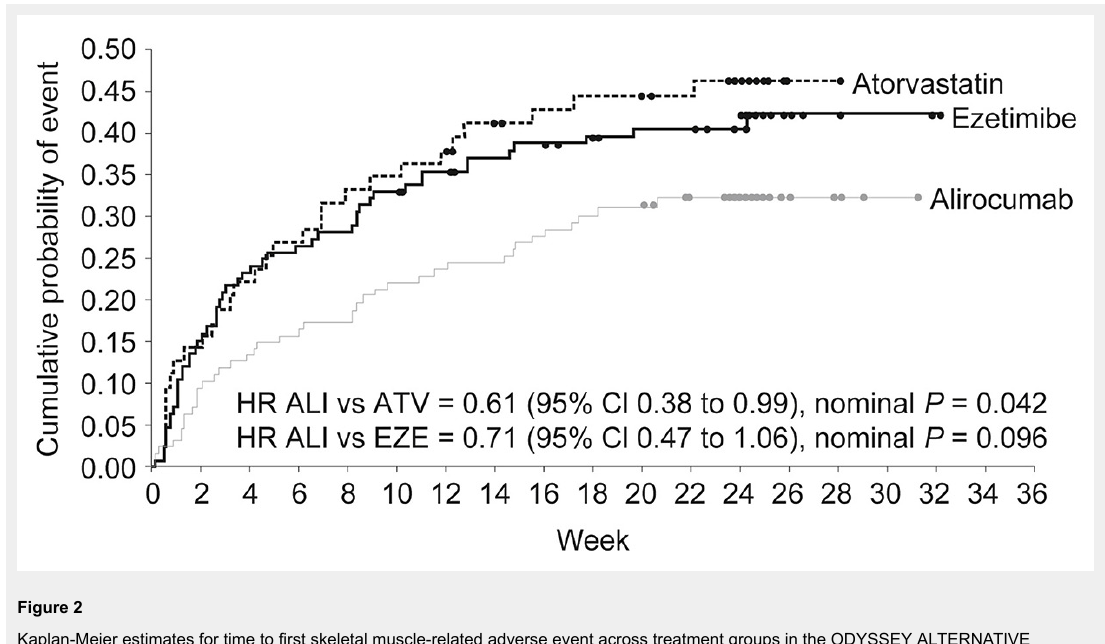
Figure 2 Kaplan-Meier estimates for time to first skeletal muscle-related adverse event across treatment groups in the ODYSSEY ALTERNATIVE randomised trial. Adapted with permission from [10]. ALI = alirocumab; ATV =atorvastatin; CI = confidence interval; EZE = ezetimibe; HR = hazard